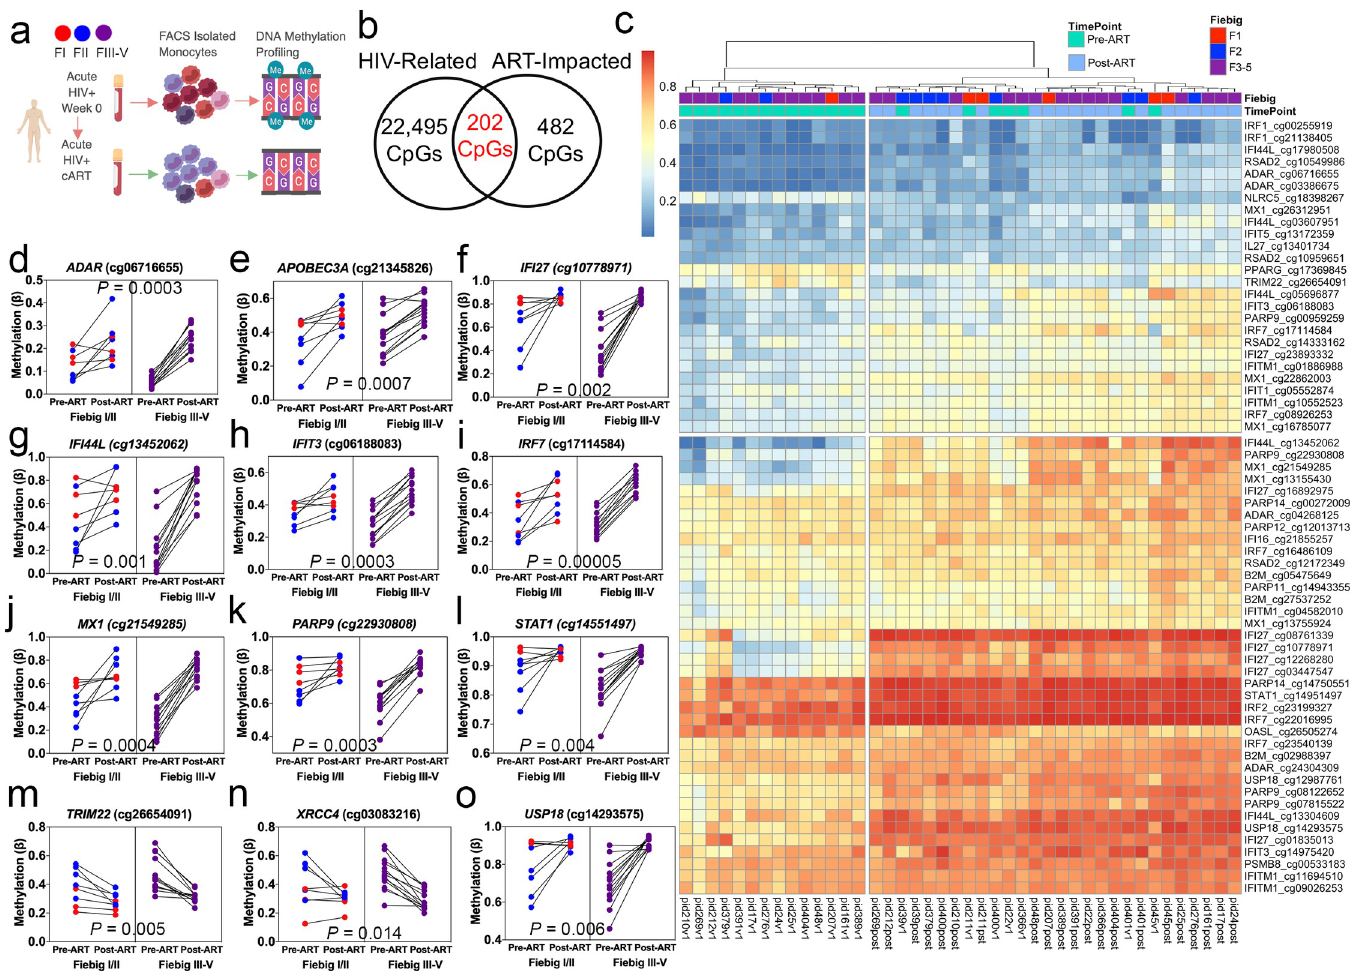
Fig 4. Early initiation of ART during acute infection minimally impacts monocyte cell type-specific differentially methylated loci associated with acute HIV infection. (a) Diagram of longitudinal experimental design utilized to identify DML-related to ART treatment in purified monocytes. Created with BioRender.com (b) Venn diagram displaying the overlap of DML between DNA methylation sites identified in monocytes related to AHI and DNA methylation sites identified in monocytes that changed before and after early initiation of ART during AHI. (c) Heatmap showing the unsupervised clustering of DML at annotated protein-coding genes related to interferon at pre-ART (aqua color) and post-ART (light blue) timepoints for AHI participants staged at Fiebig I (red color), II (blue color), or III-V (purple color). Dendrogram shown above. Colors in the heatmap indicate CpG methylation levels (blue to red: low to high methylation levels). (d-o) Plots displaying longitudinal DNA methylation levels of AHI participants at Pre-ART and Post-ART timepoints by Fiebig stage. Red dots represent individuals in Fiebig I. Significance determined comparing repeated measures comparison of Pre-ART vs. Post-ART and using FDR adjusted P-values <